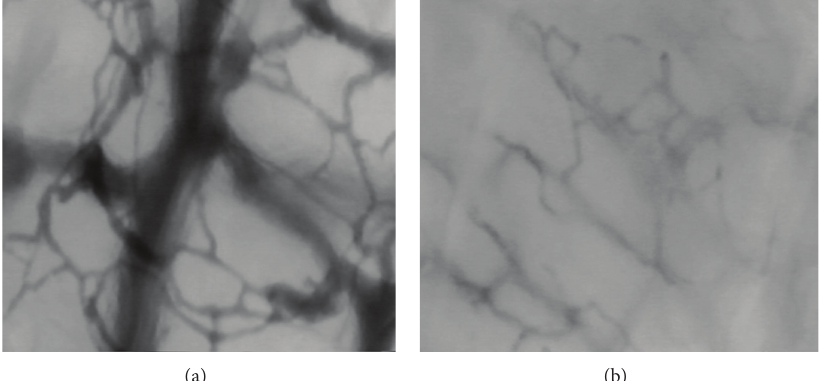
and 95 CI [87–94]) and the infection groups (68 % %